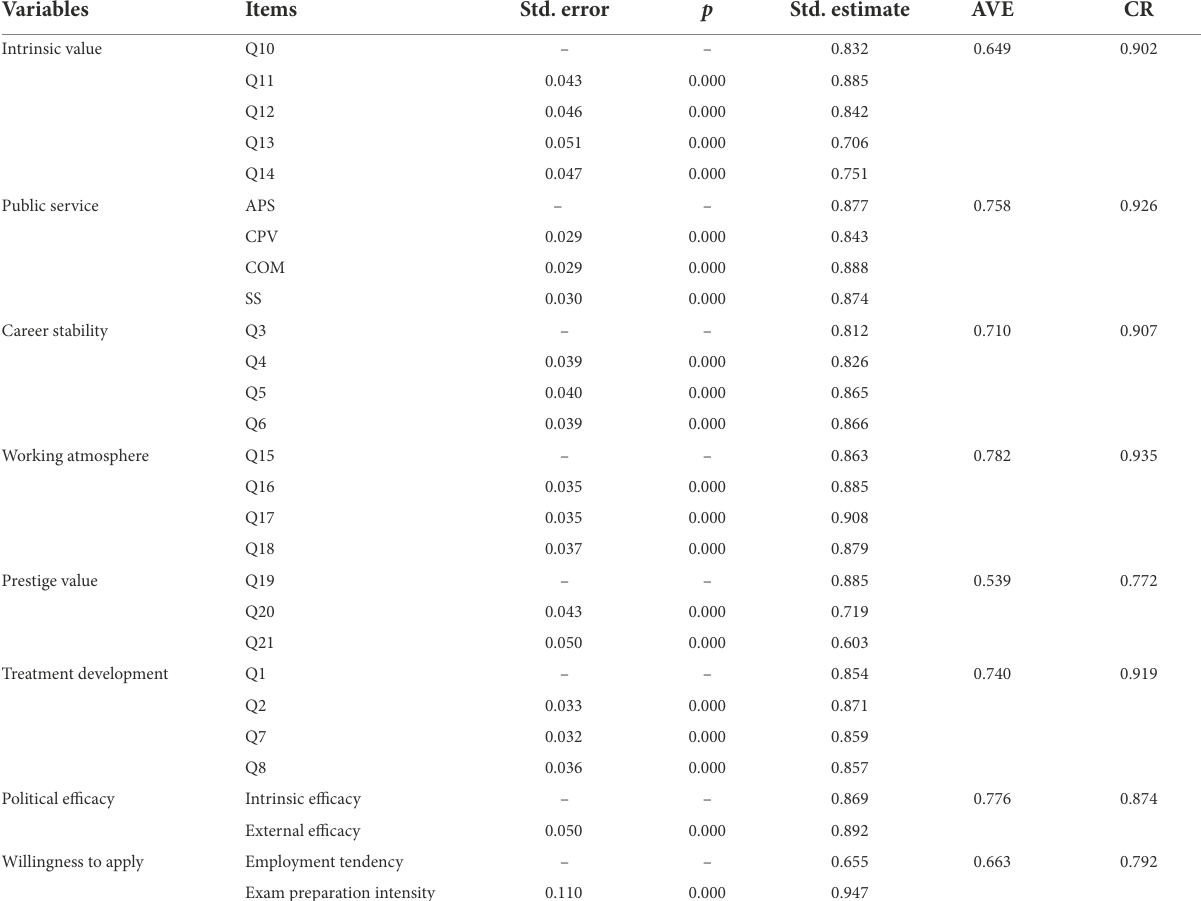
TABLE 3 Results of reliability and validity